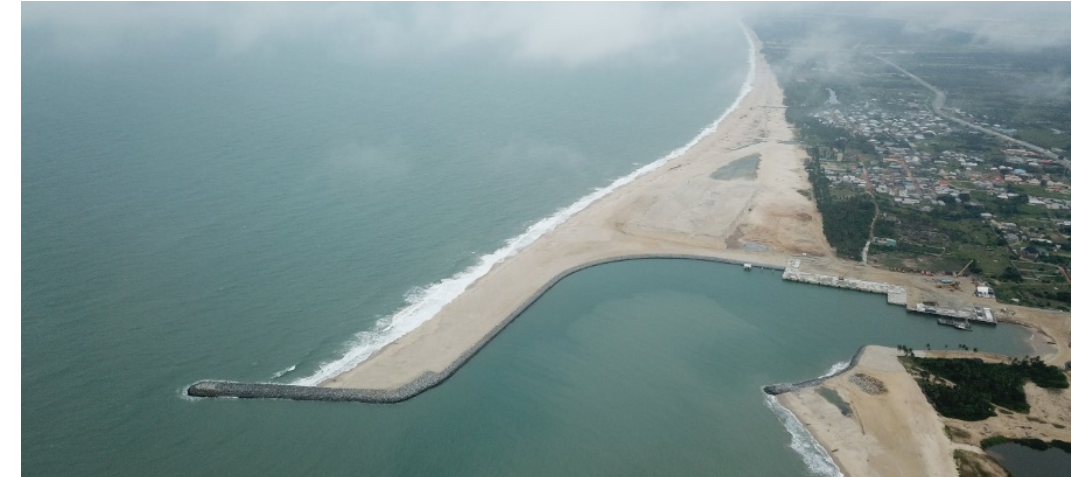
Figure 5. Westward looking aerial photograph of the Sandbar Breakwater at Lekki, Nigeria, a couple of months after construction (image courtesy of CDR International B.V.).